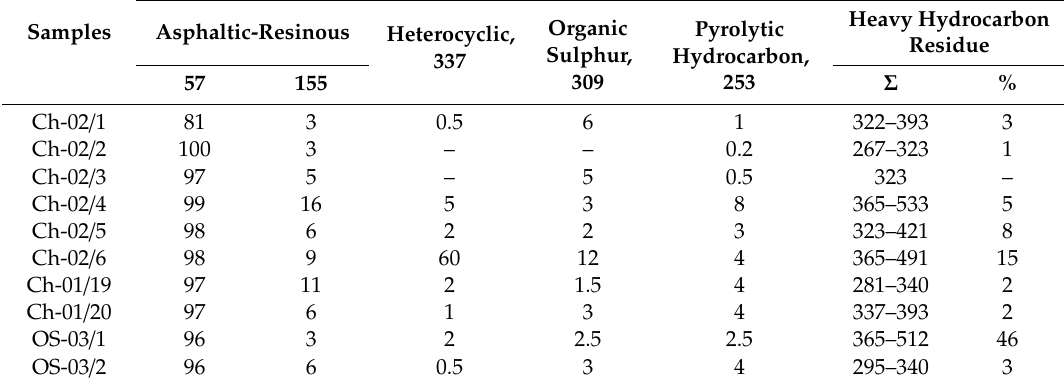
Table 1. The relative intensities of main components of pyrolysis products of coal-bearing deposits of spoil heaps according to mass